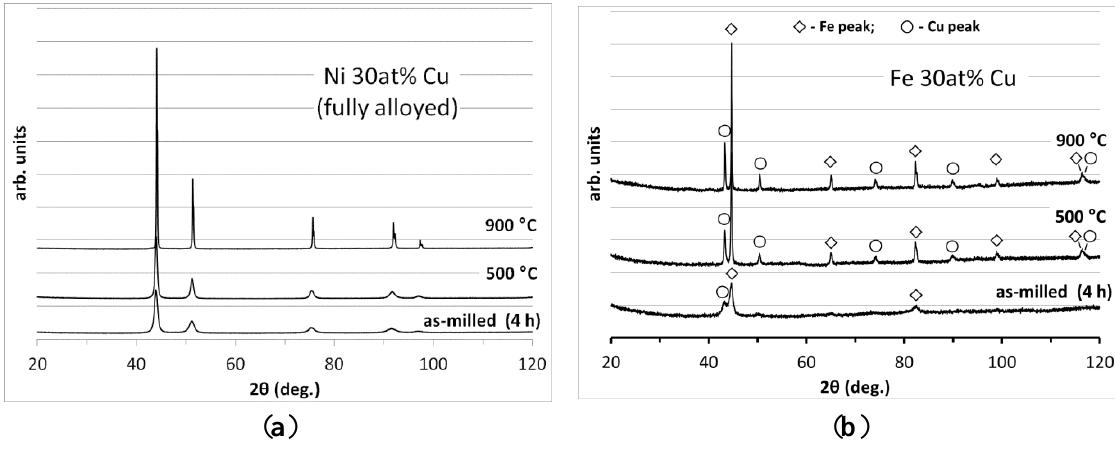
Figure 1. XRD patterns at listed milling times for ( a ) Ni 30 at% Cu and ( b ) Fe 30 at% Cu.